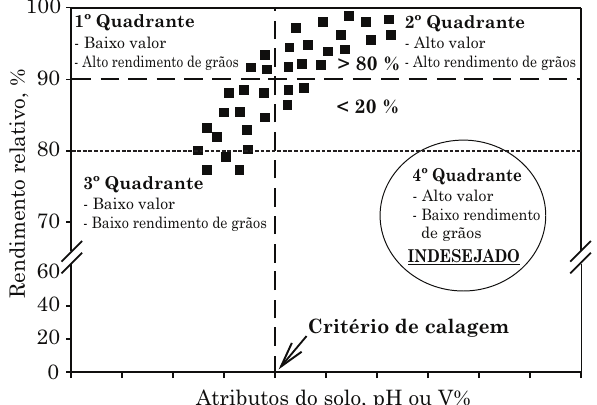
Figura 1. Esquema teórico do método da divisão por quadrantes utilizados para a definição dos critérios de calagem. Adaptado de Cate & Nelsonm (1971).